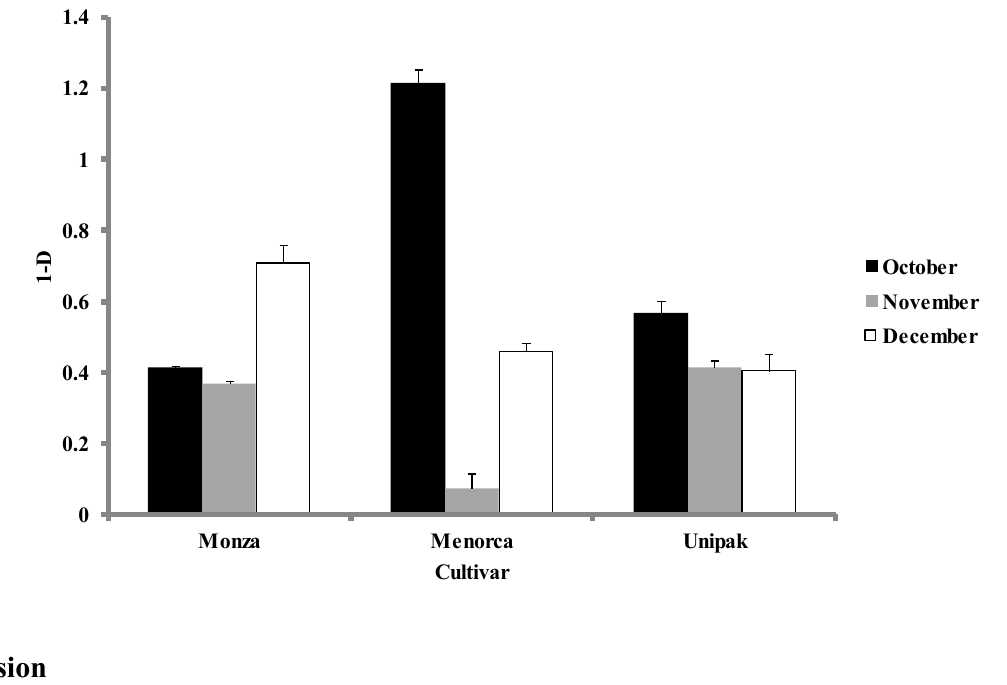
Figure 4. Simpson’s diversity indices (D) calculated based on the abundance of members of five phyla in communities isolated from three spinach cultivars during harvested at three different sampling times. (Simpson’s diversity index was represented as 1-D to facilitate the analysis). Independent replicates were used (n = 3). Error bars represent standard deviation of the